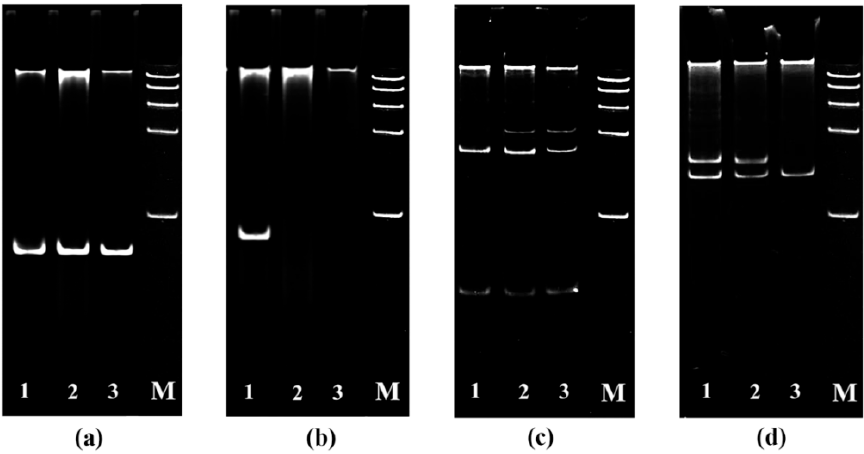
Figure 1. Identification of alleles of susceptibility genes Snn1 ( a ), Tsn1 ( b ) with using primers for the intragenic markers and Snn3-B1 locus Table ( c , d ) using primers for SSR markers Xcfd20 ( c ) and Xgwm234 ( d ) in different wheat cultivars by PCR. 1—Zhnitsa; 2—Kazakhstanskaya 10; 3—Omskaya 35; M—DNA molecular weight ladder 100–1000 bp.